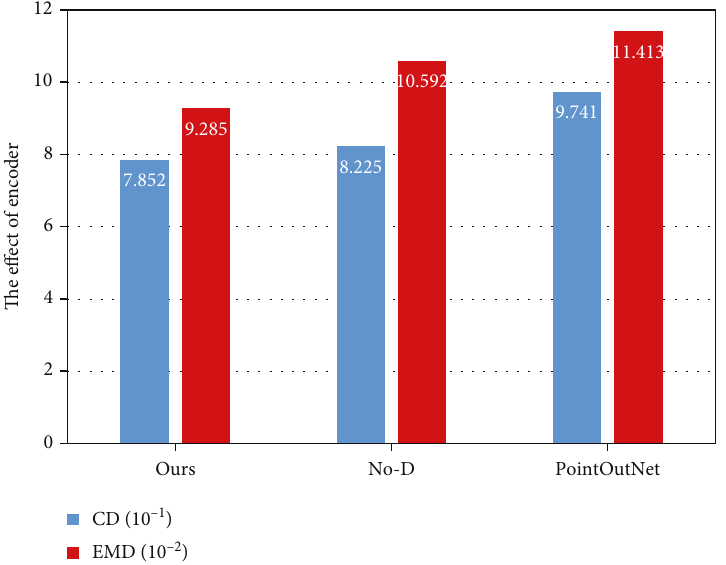
Figure 6: The e ff ect of di ff erent stage I generating